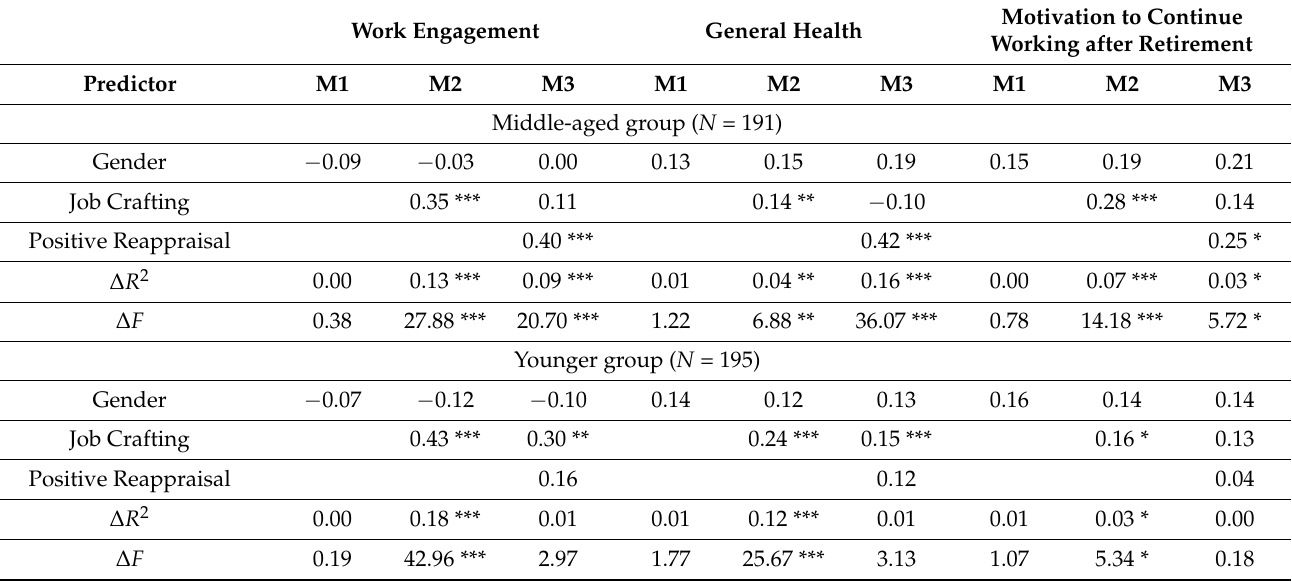
Table 6. Results from hierarchical regression analyses of Positive Reappraisal predicting healthy ageing at work.